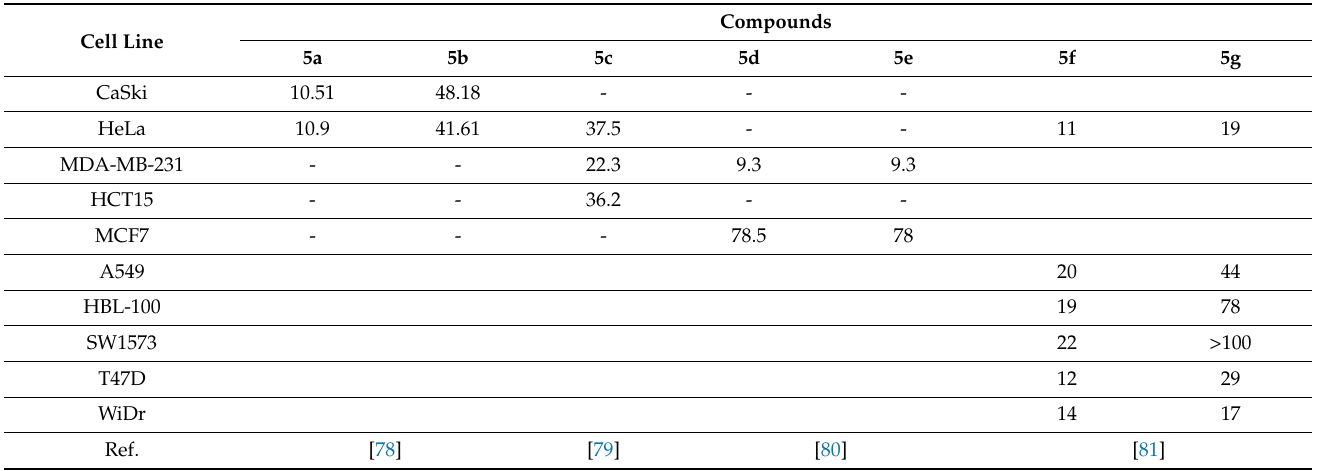
Figure 8. Steroidal diosgenin oxime derivatives with antitumor activity in several types of cancer cells. Table 7. IC 50 values (µM) of the synthesized diosgenin oxime derivatives.